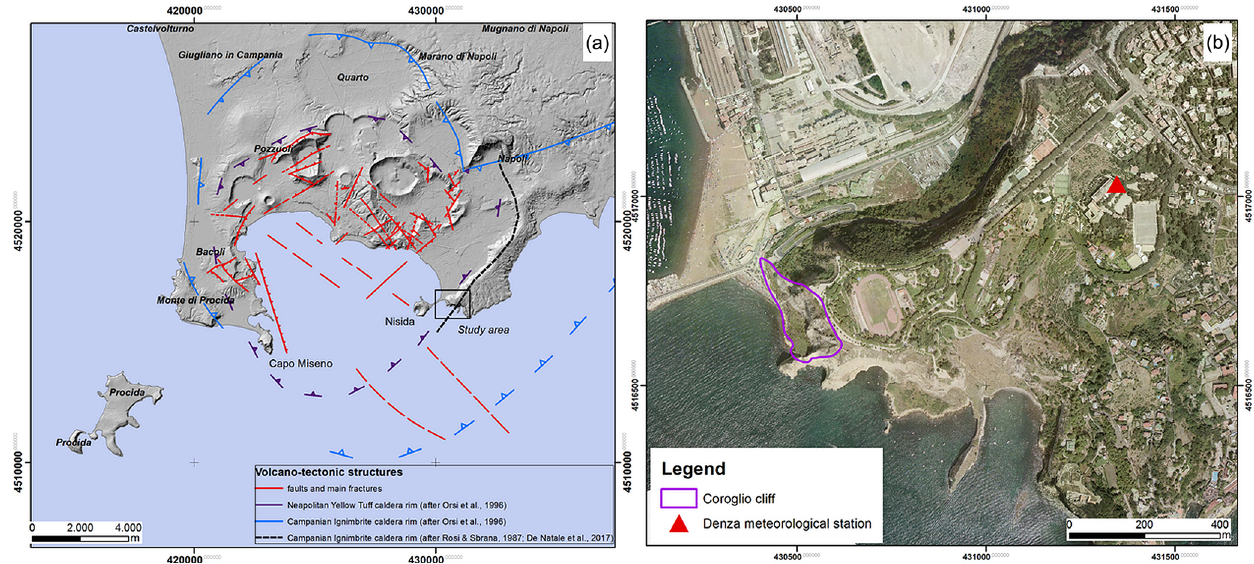
Figure 1. (a) Study area location and Phlegraean Fields area. (b) Detailed study area orthophoto (2004). The hillshade (a) and the orthophoto (b) in the background are from the year 2004 (courtesy of Regione Campania). Hillshade derives from a 5m pixel DTM of the Carta Tecnica della Regione Campania (CTR) topographic map at 1 : 5000 scale, with 447153 and 465034 sheets (https://sit2.regione.campania.it/content/ carta-tecnica-regionale-2004-2005; last access: 5 January 2020). The orthophoto is a mosaic of 447153 and 465034 orthophoto maps at the 1 : 5000 scale (https://sit2.regione.campania.it/content/ortofoto-campania-20042005; last access: 5 January 2020).